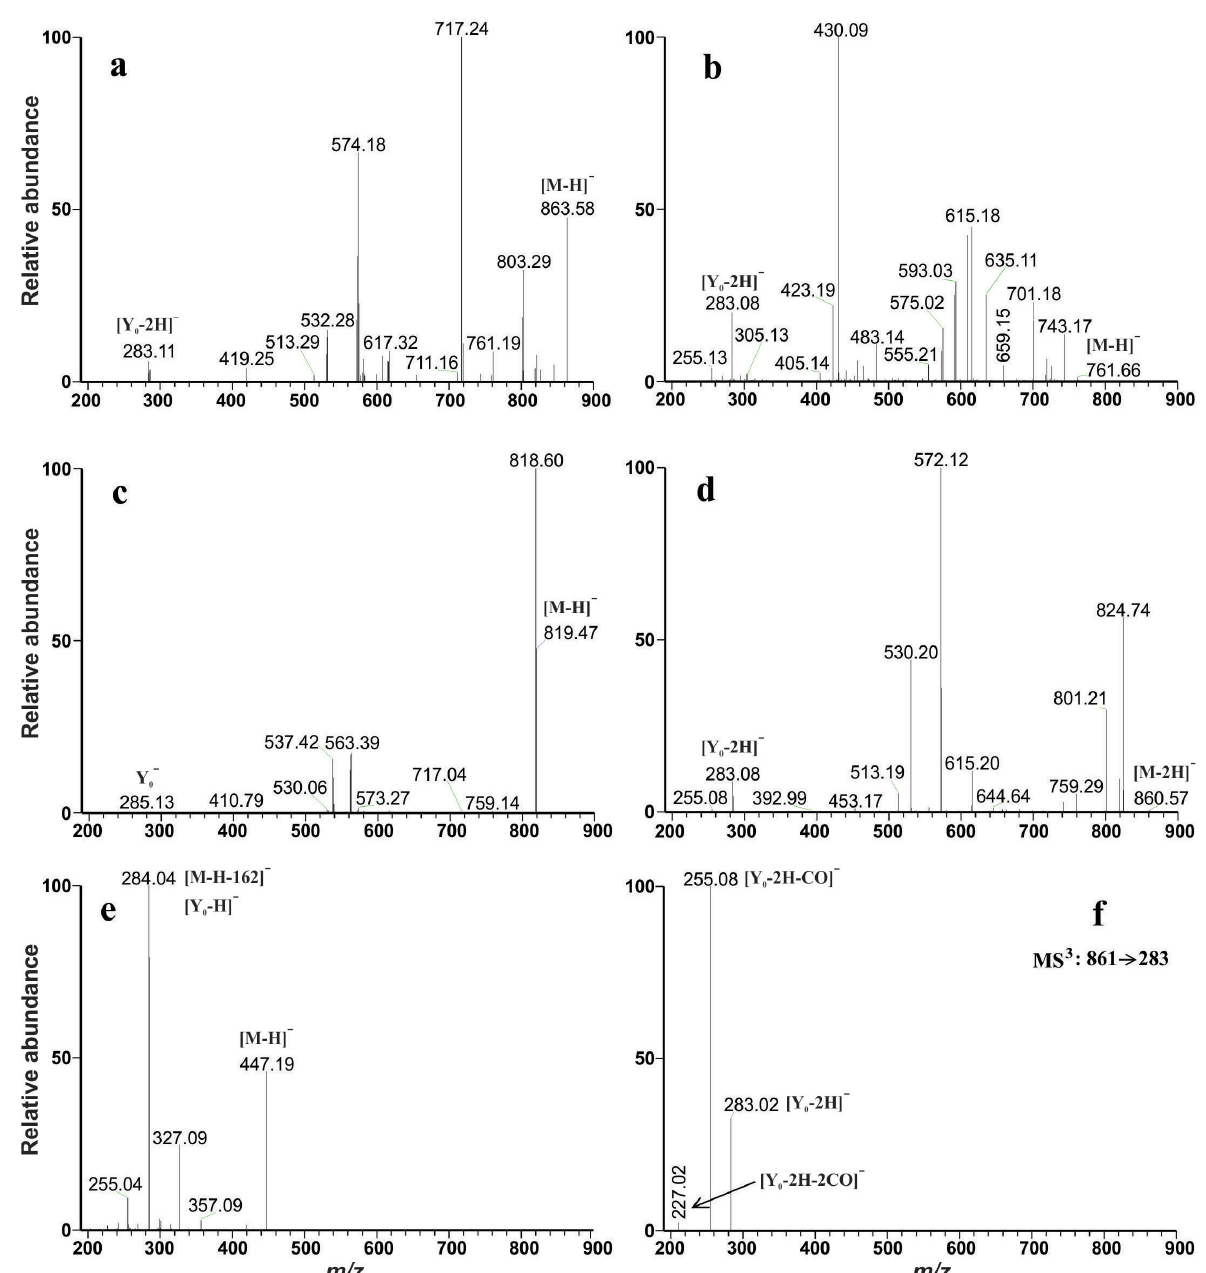
Fig. 5: ESI-MS/MS spectrum of kaempferol derivatives. MS 2 of the [M − H] − ion of compounds: (a) 6K , (b) 7K , (c) 8K , (d) 9K of E. kimnachii and (e) 12S of E. subrigida ; (f) MS 3 (861 → 283) of compound 9K